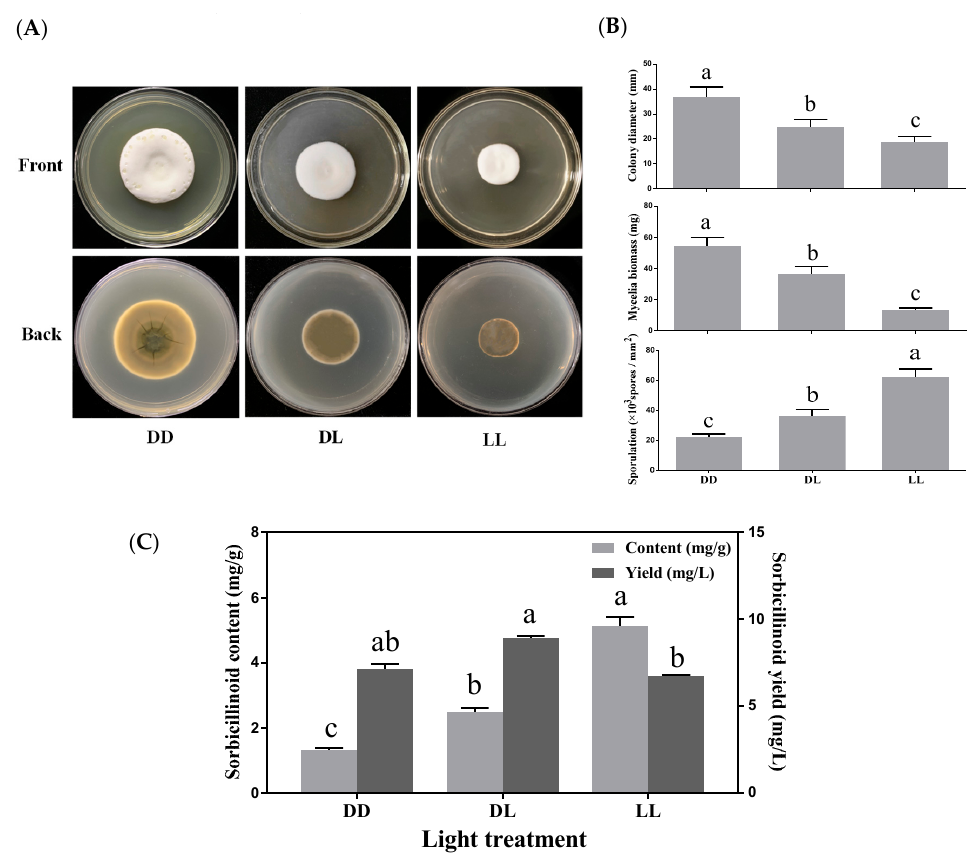
Figure 4. Effects of light exposure on colony extension, mycelial biomass, sporulation and sorbicillinoid production of U. virens . ( A ) Colony morphology of U. virens, cultured for 18 days at 28 °C, on PBGB medium with different light treatments; ( B ) Effects of light exposure on colony diameter, mycelial biomass and the sporulation of U. virens ; ( C ) Effects of different light treatments (DD, 24 h dark/day; LL, 24 h light/day; DL, 12 h dark–12 h light/day) on sorbicillinoid content (mg/g) and yield (mg/L). Bars represented standard deviations of the means. Di ff erent le tt ers in each fi gure mean signi fi cant di ff erences according to Duncan’s Multiple Range Test ( p < 0.05).